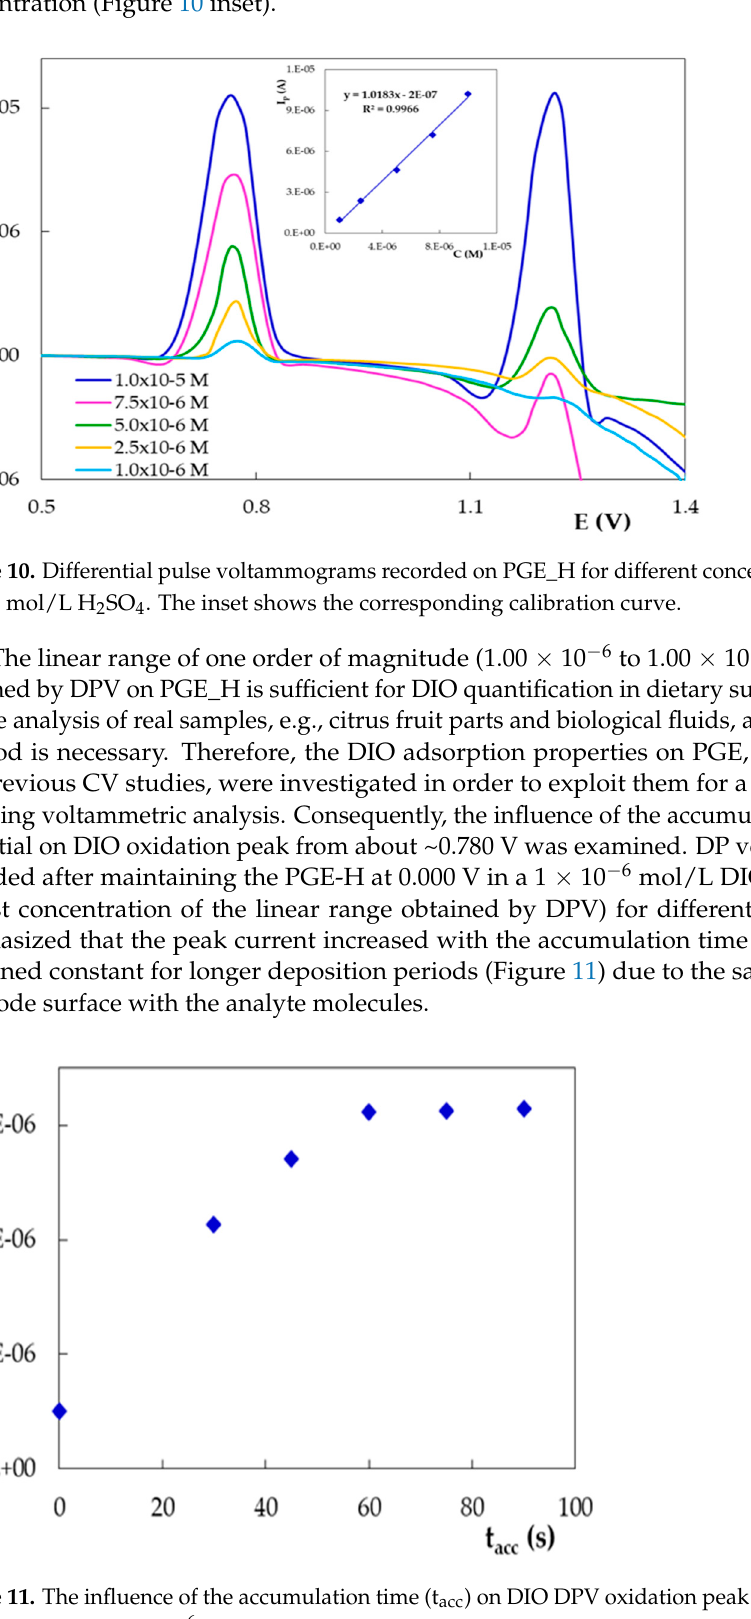
not affected by the background current. The current of this peak varied linearly with DIO concentration (Figure 10 inset).